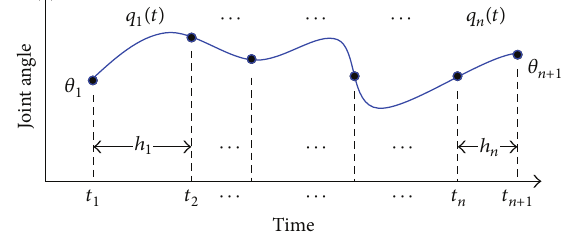
Figure 5: Cubic spline